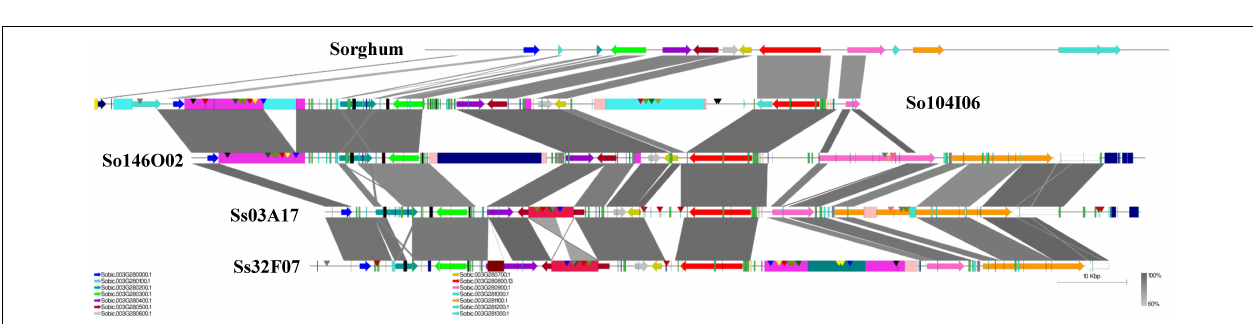
FIGURE 1 | Mapping the Saccharum BACs on sorghum chromosomes. Homologous groups of two, three, and four BACs are shown in blue, red, and green, respectively. # : These homologous BACs were identified by Blast.